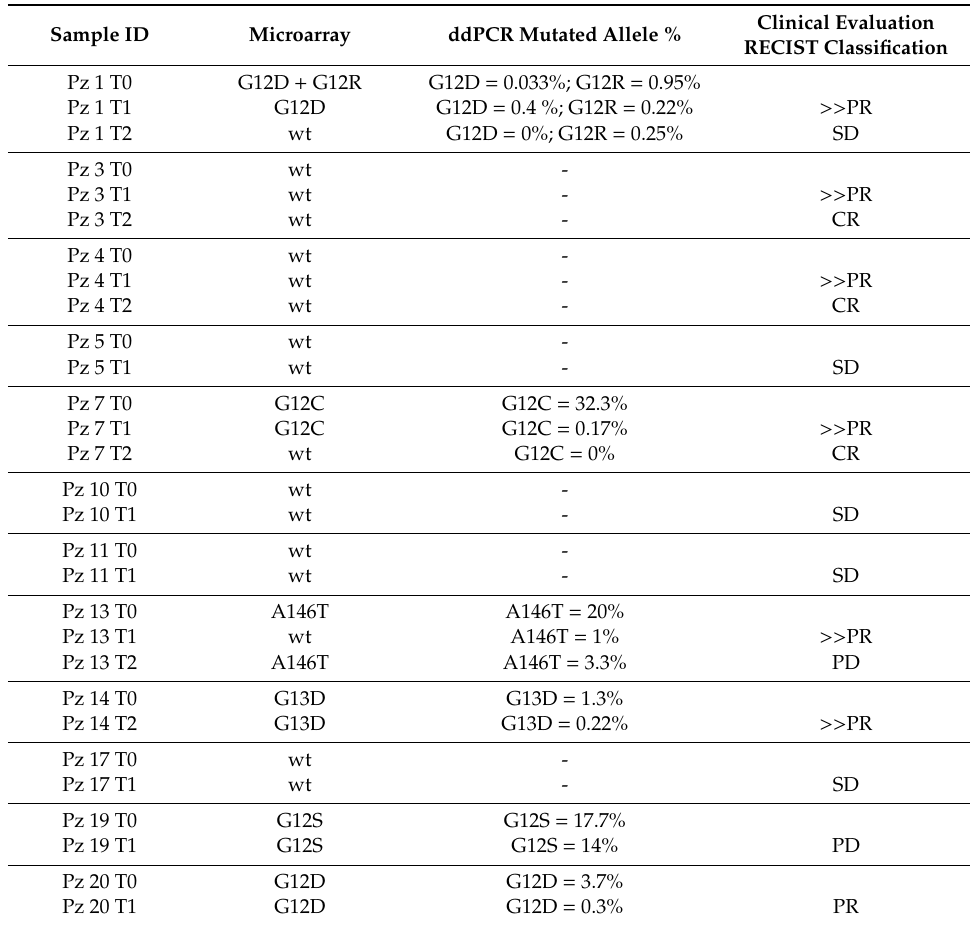
Table 3. Comparison of liquid biopsy results from patients’ enrolment at T1 and T2 and clinical